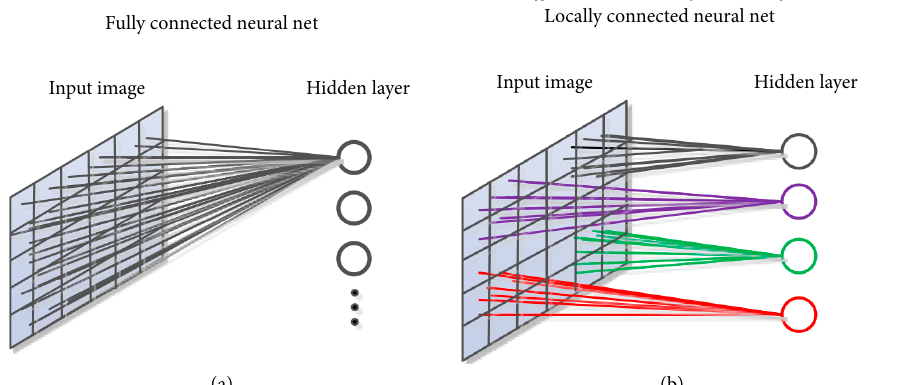
Figure 5: Fully connected neural net and locally connected neural net